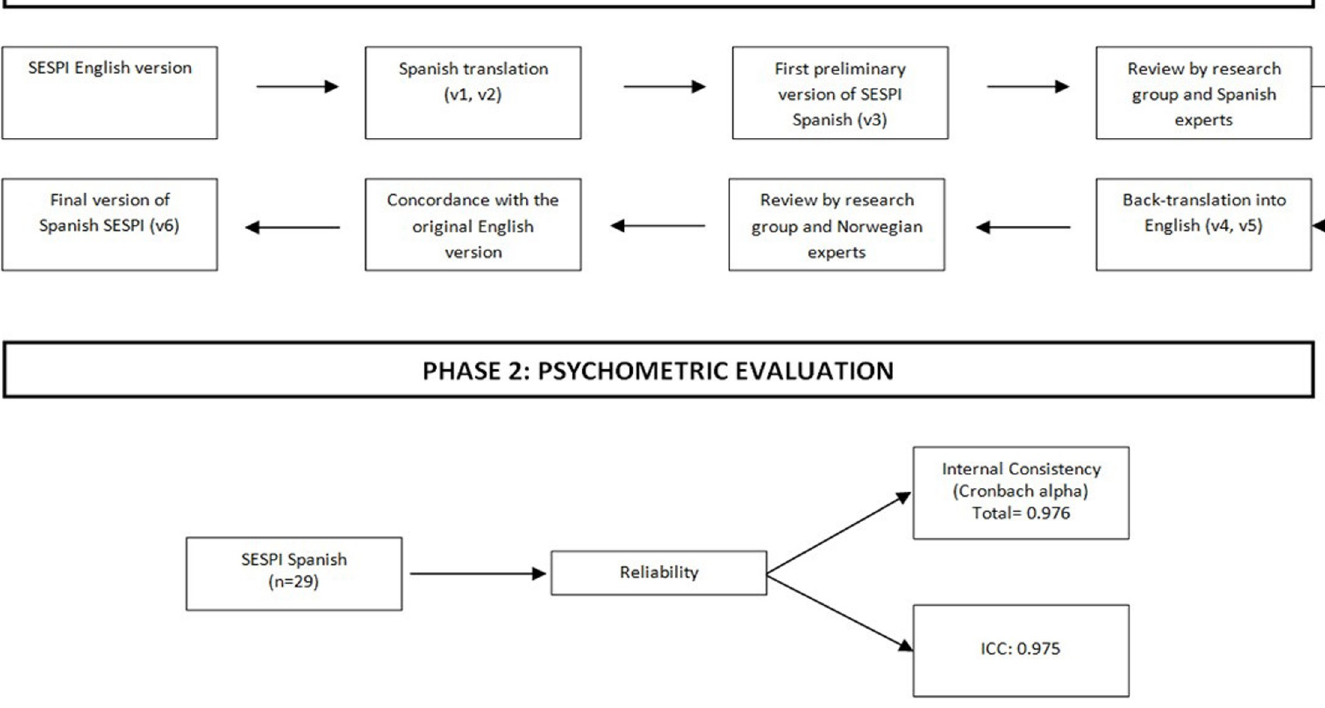
Fig 1. Overview of the two-phase